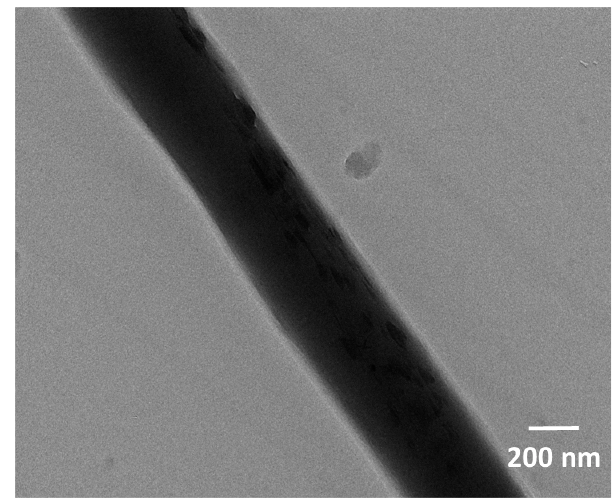
Figure 4. TEM image of PLA/chitosan fibres. Polymers 2018 , 10 , x FOR PEER REVIEW 9 of 16